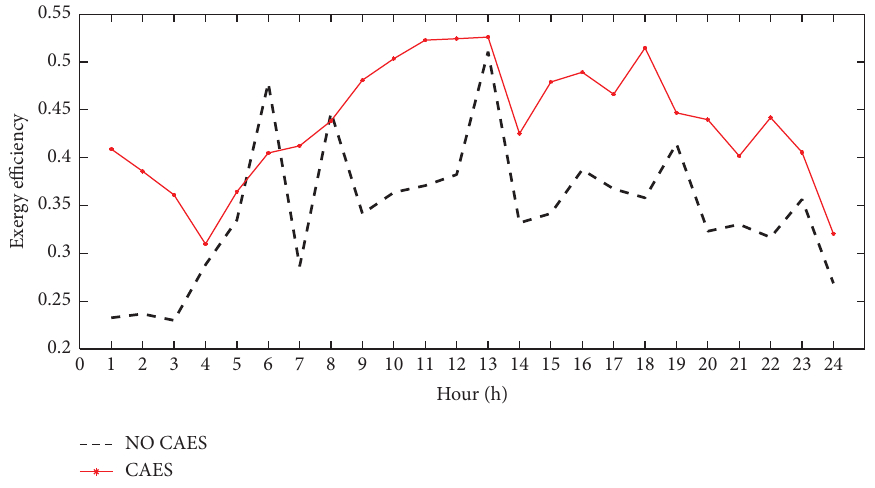
Figure 23: Exergy efciency with and without CAES in